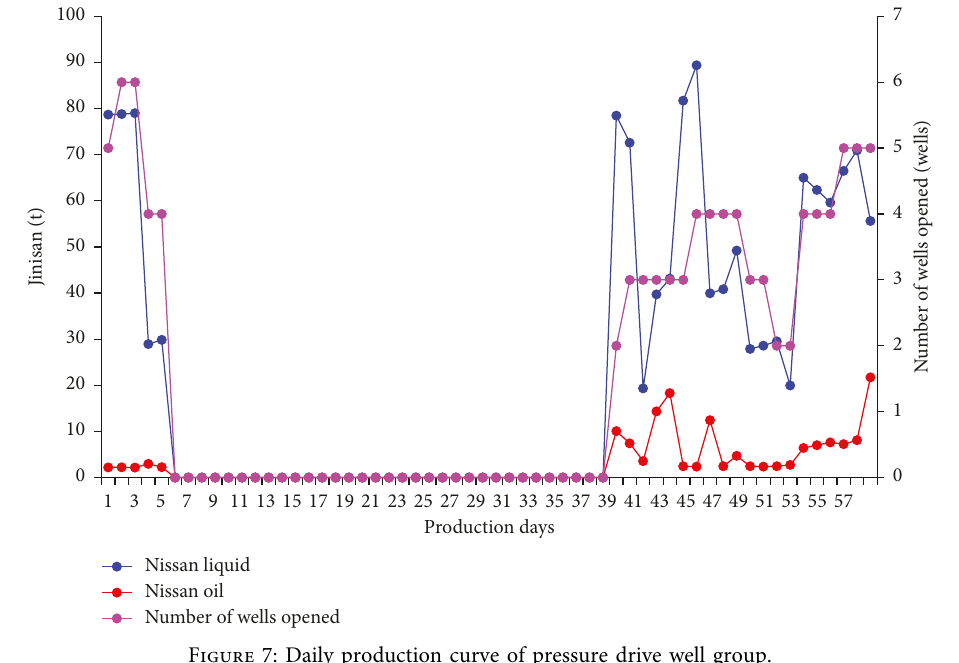
Figure 7: Daily production curve of pressure drive well